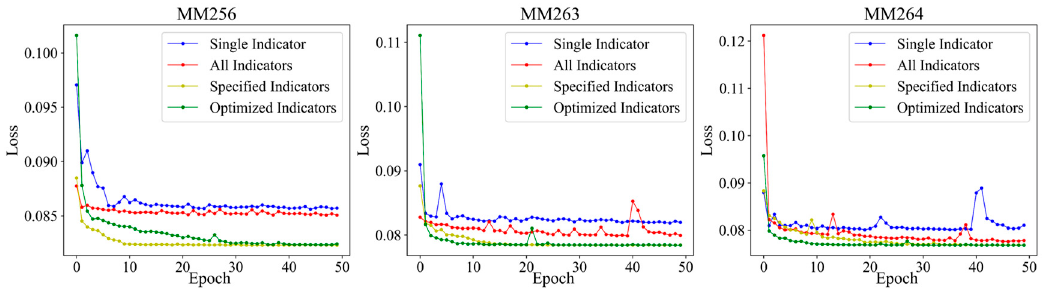
Figure 12. The changes of Loss with Epoch .